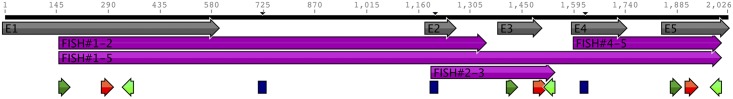
Schematic view of the porcine TSPY gene (exons 1–5 in grey) and location of primers (green), TaqMan probes (red), PflMI enzyme cut positions (blue) and FISH probes (purple).